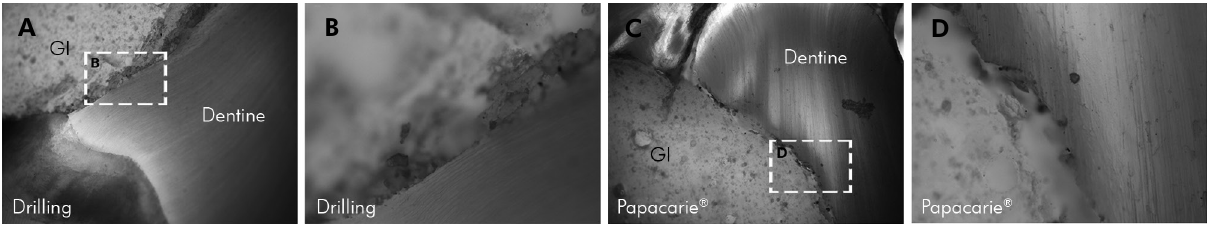
(A,B) Images of the drilling group at 5x and 20x magnification, respectively. (C,D) Images of the CMCR group at 5x and 20x magnification, respectively. GI denotes a glass-ionomer restoration. Figure 3. Polarized light microscopy images of the interface between residual dentin and GI.